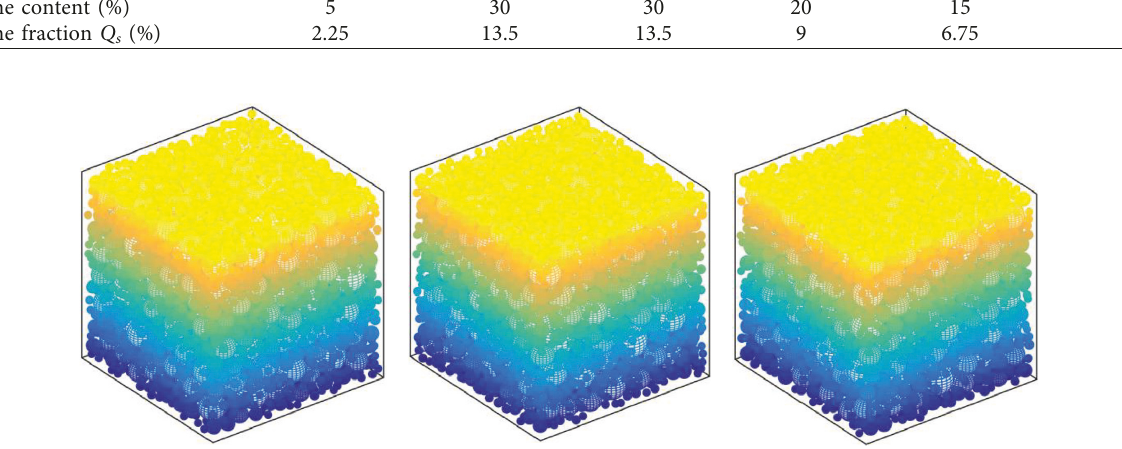
Figure 6: Geometric model of continuous-graded spherical